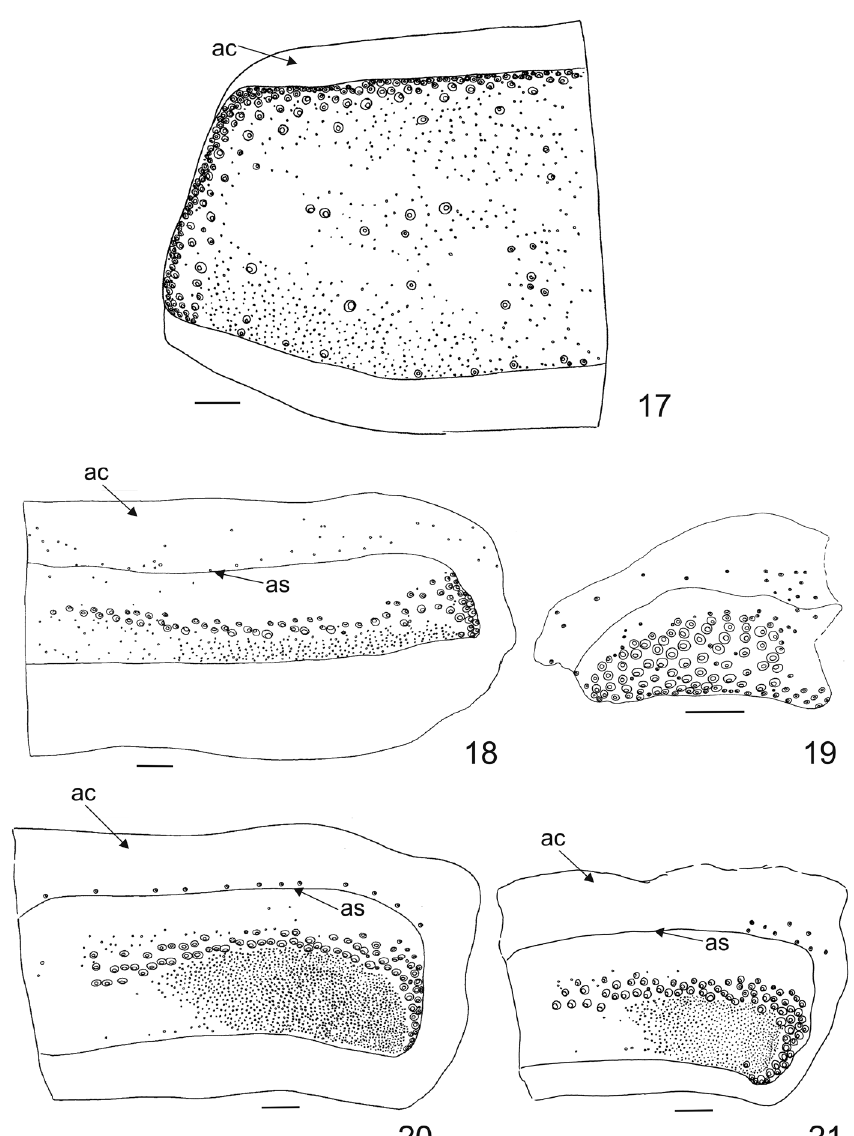
Figures 17–21. Mature larva of Megatoma ( s. str. ) undata (Linnaeus, 1758). 17 Pronotum (dorsal, left half; circles with central ring represents points of insertion of spicisetae, small circles represents points of insertion of hastisetae) 18 Abdominal tergum I (dorsal, right half; circles with central ring represents points of insertion of spicisetae, small circles represents points of insertion of hastisetae) 19 Abdominal tergum IX (dorsal, circles with central ring represents points of insertion of spicisetae) 20 Abdominal tergum VII (dorsal, right half; circles with central ring represents points of insertion of spicisetae, small circles represents points of insertion of hastisetae) 21 Abdominal tergum VIII (dorsal, right half; circles with central ring represents points of insertion of spicisetae, small circles represents points of insertion of hastisetae). Scale bar 0.1